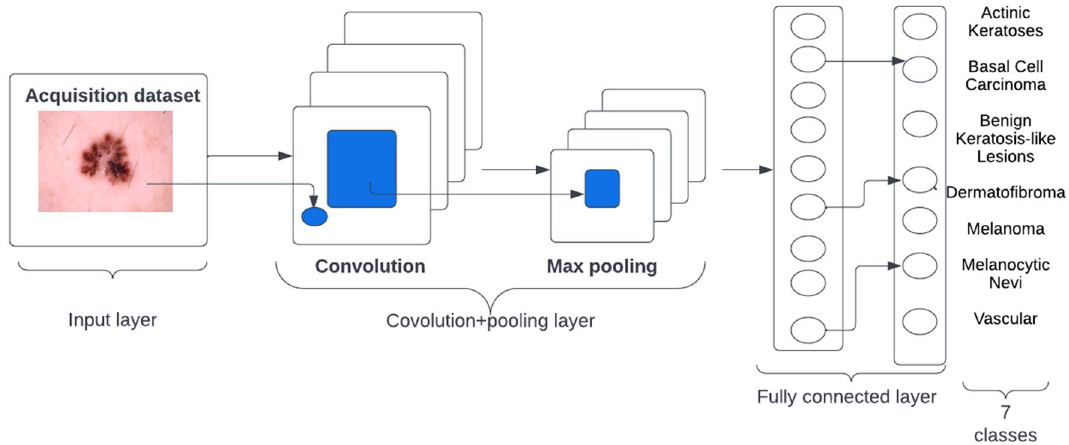
Figure 4. A high-level overview of CNN